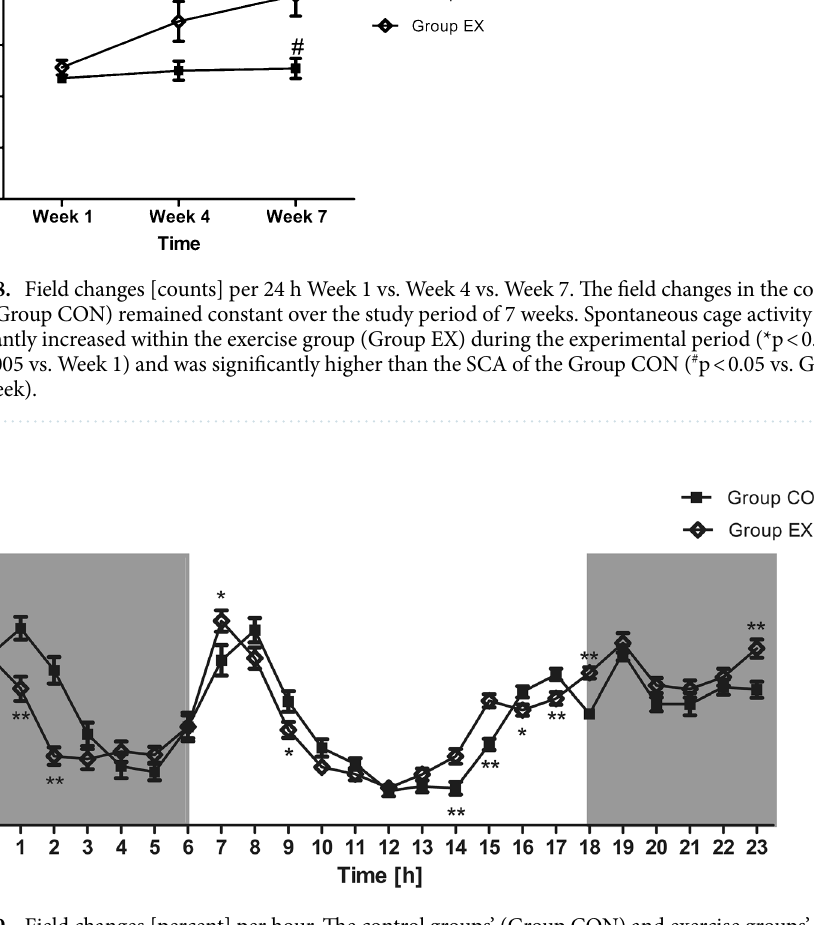
Figure 9. Field changes [percent] per hour. The control groups’ (Group CON) and exercise groups’ (Group EX) daily movement patterns were similar with some significant deviations (Group CON vs. Group EX at the time *p < 0.05 and **p <